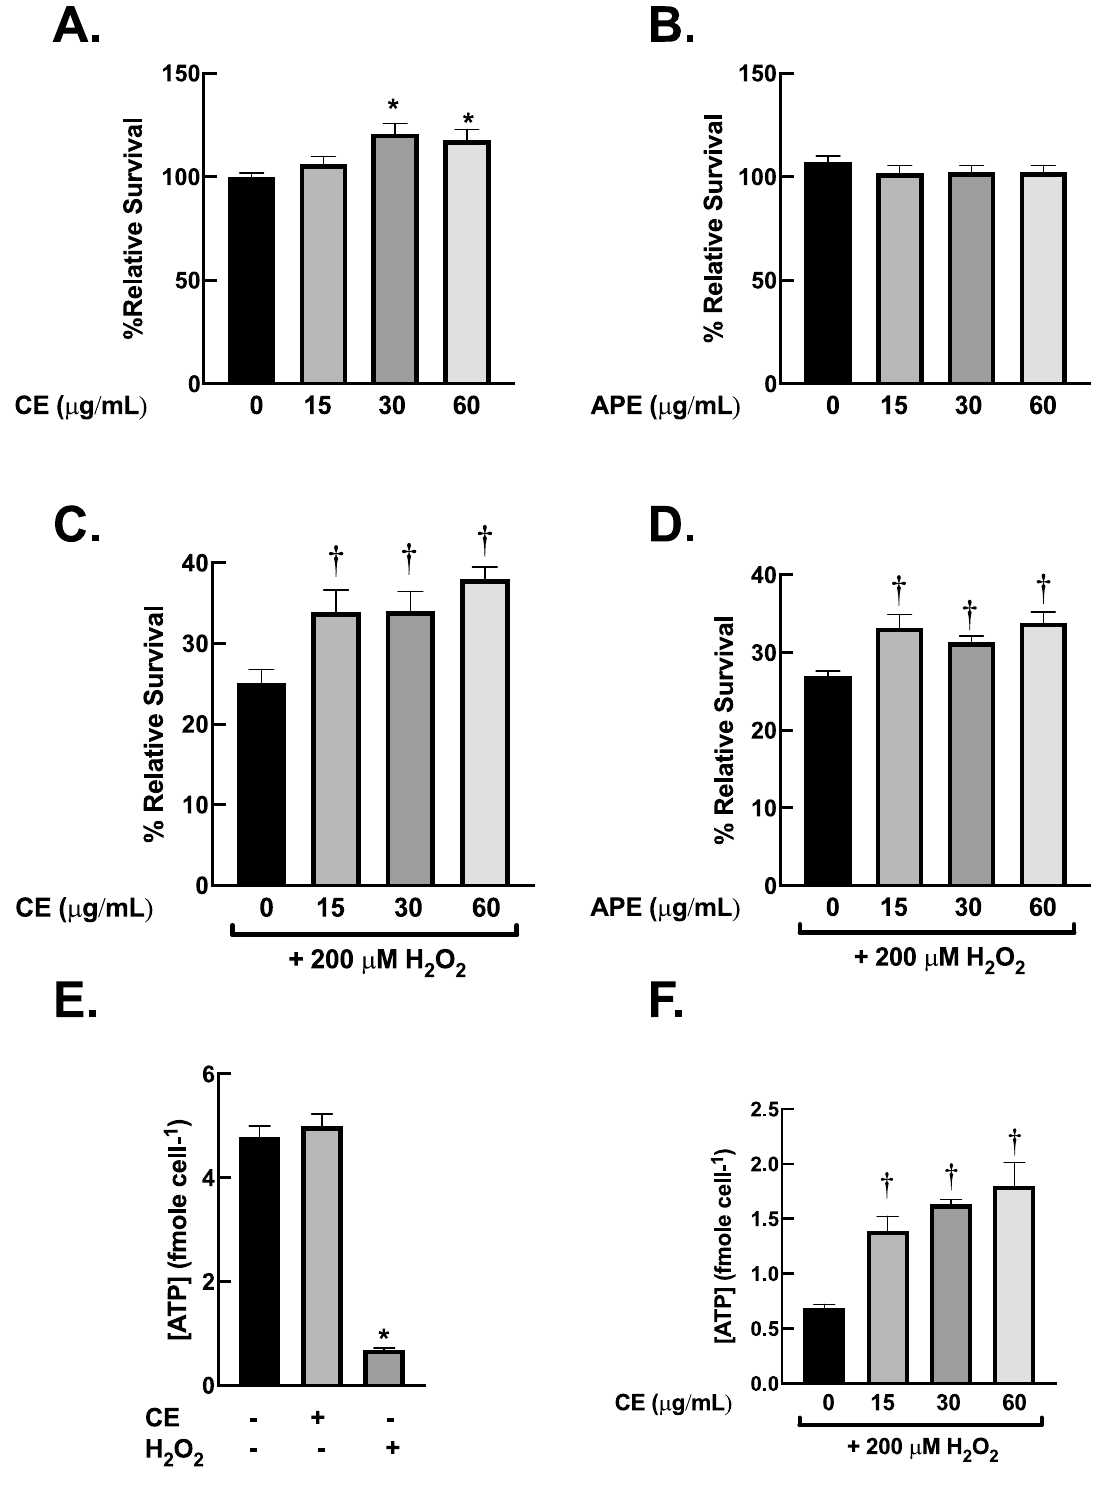
Figure 4. Centella extracts prevent H 2 O 2 -induced cytotoxicity in dermal fibroblasts. ( A ) and ( B ) CE and APE at 15–60 µg/mL did not cause toxicity in dermal fibroblasts. BJ cells were incubated with CE or APE (15–60 µg/ mL) for 24 h. ( C ) and ( D ) CE and APE inhibit oxidative damage from H 2 O 2 exposure. BJ cells were pre- incubated with CE or APE (15–60 µg/mL) for 24 h then exposed to H 2 O 2 (200 µM) for 1 h. The cell viability was evaluated with MTT assay immediately after the treatments. ( E ) and ( F ) CE inhibit depletion of intracellular ATP following H 2 O 2 exposure. The protocol for treatment was as ( A ) and ( C ). The amounts of ATP were measured immediately after treatments ( n = 3; mean ± SEM; * P < 0.05 vs untreated control; † P < 0.05 vs H 2 O 2 - treated